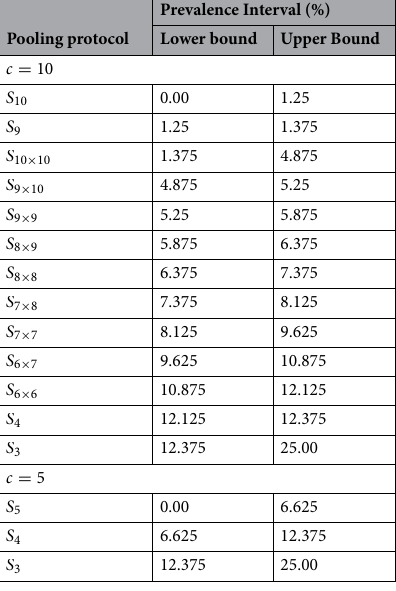
Table 1. Optimal pooling strategies restricted by a maximum pool size c . Prevalence intervals and their respective optimal pooling strategy. S m are single pooling protocols and S m × n are matrix pooling protocols.